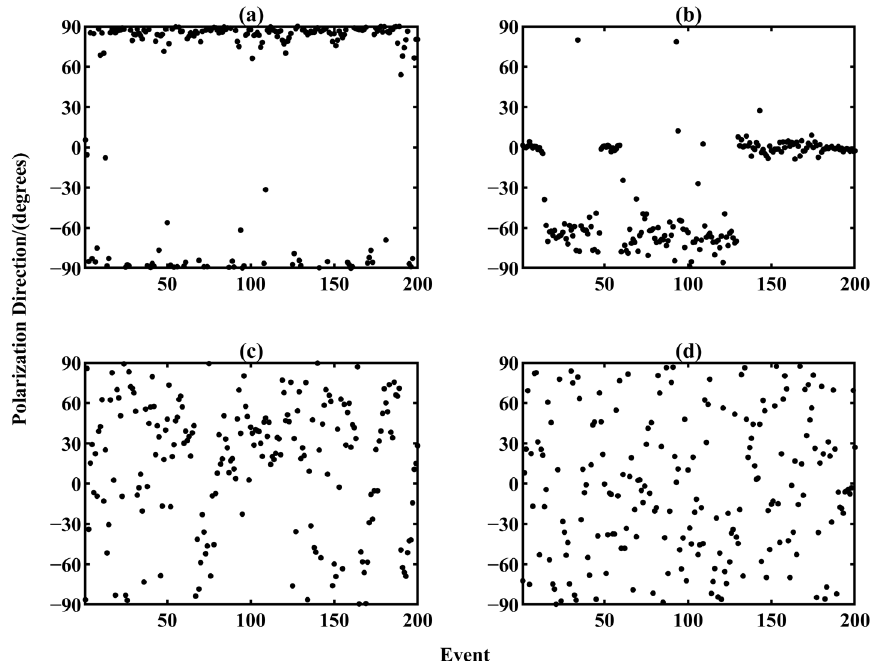
Figure 17. The polarization direction of the 12th test dataset. The electric field of ( a ) noise data and ( c ) denoising data at 0.2 Hz. The magnetic field of ( b ) noise data and ( d ) denoising data at 0.2 Hz. Dots denote the polarization direction of different data sections.